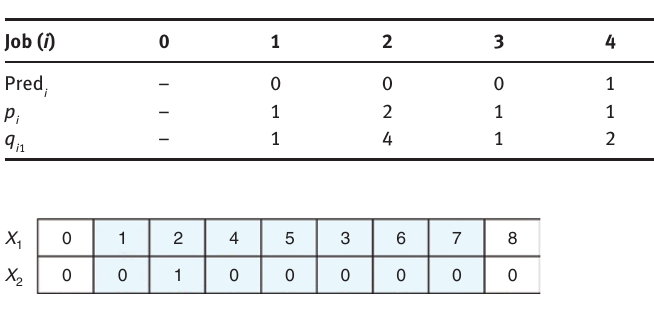
Table 2: An Example with Nine Jobs.